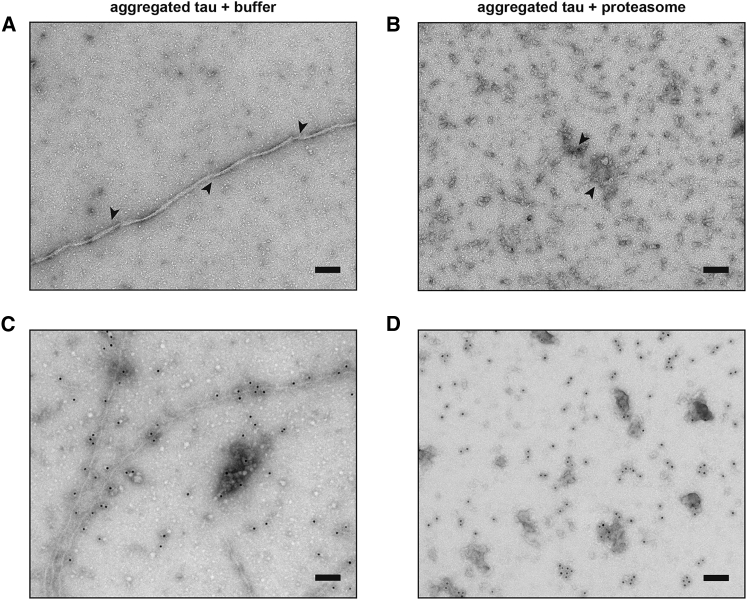
Disordered Aggregates of Amorphous Structures Detected by TEM after Fragmentation by the Proteasome(A and B) Aggregated tau samples prepared as in Figure 2 were incubated with (A) an ATP-containing buffer or (B) proteasome holoenzyme for 20 h, stained with uranyl acetate, and imaged by TEM. Arrows indicate typical aggregated structures.(C and D) Aggregated samples incubated with (C) the buffer control or (D) the proteasome were immunolabeled with an anti-tau antibody, stained with uranyl acetate, and imaged by TEM.The scale bars represent 100 nm. Representative images are shown of at least three independent repeats.